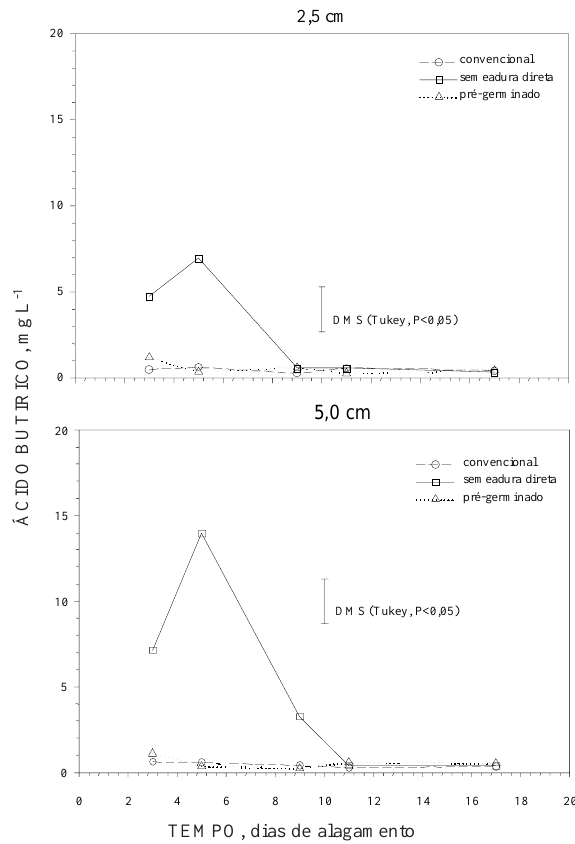
Figura 4. Concentração de ácido butírico na solução de um Gleissolo, em duas profundidades (2,5 e 5,0 cm), em três sistemas de cultivo de arroz durante 17 dias de alagamento do